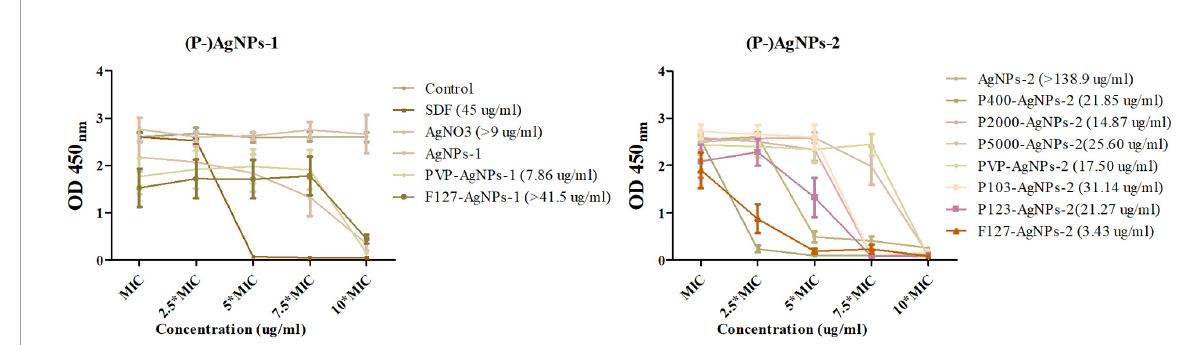
The peak values of all AgNPs and P-AgNPs were between 390 and 410 nm, which is the characteristic plasmon resonance absorption peak of typical spherical silver nanoparticles (Udaya et al., 2010). The hydrated size of P-AgNPs increased